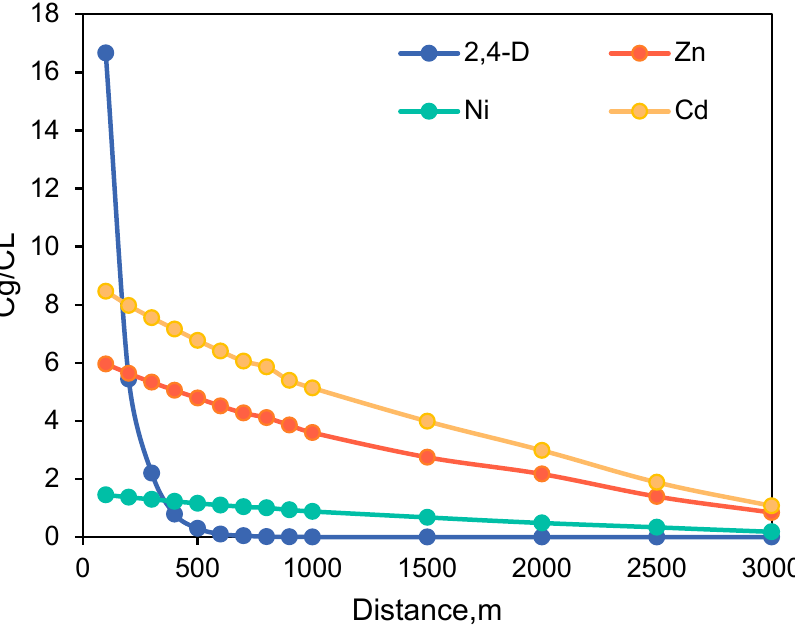
Figure 4. Ratio of predicted contaminant concentrations (C g ) to concentration limits (C L ) at different distances.